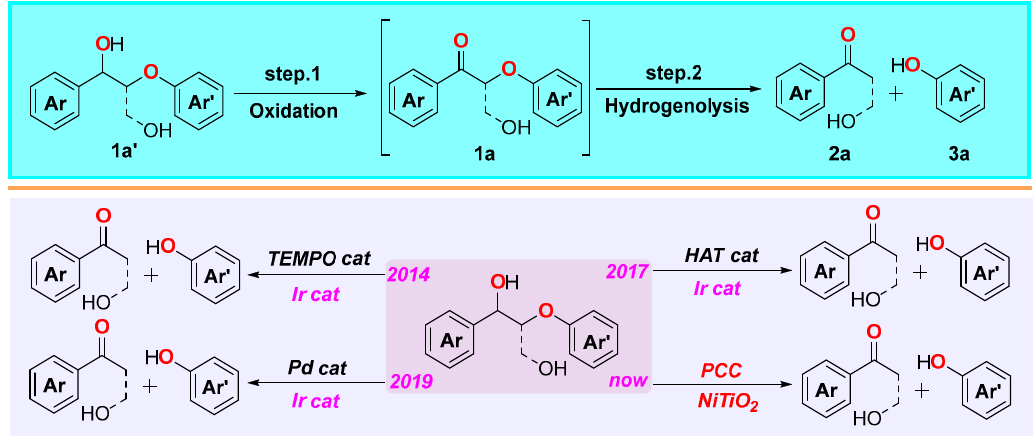
Scheme 2. Two-step method for the fragmentation of β - O -4 alcohol to valued-added Table 4. Optimization of the oxidants for the cleavage of β - O -4 alcohols in one-pot a .